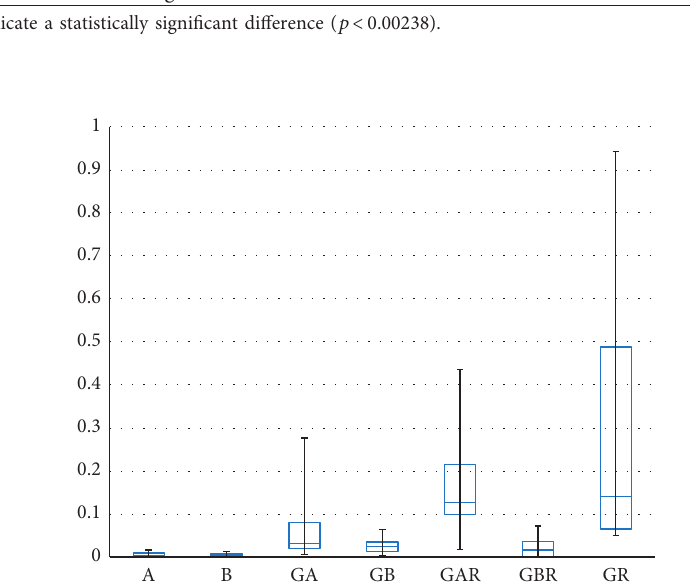
Figure 4: Box and Whisker plot of the leakages (nL/s).